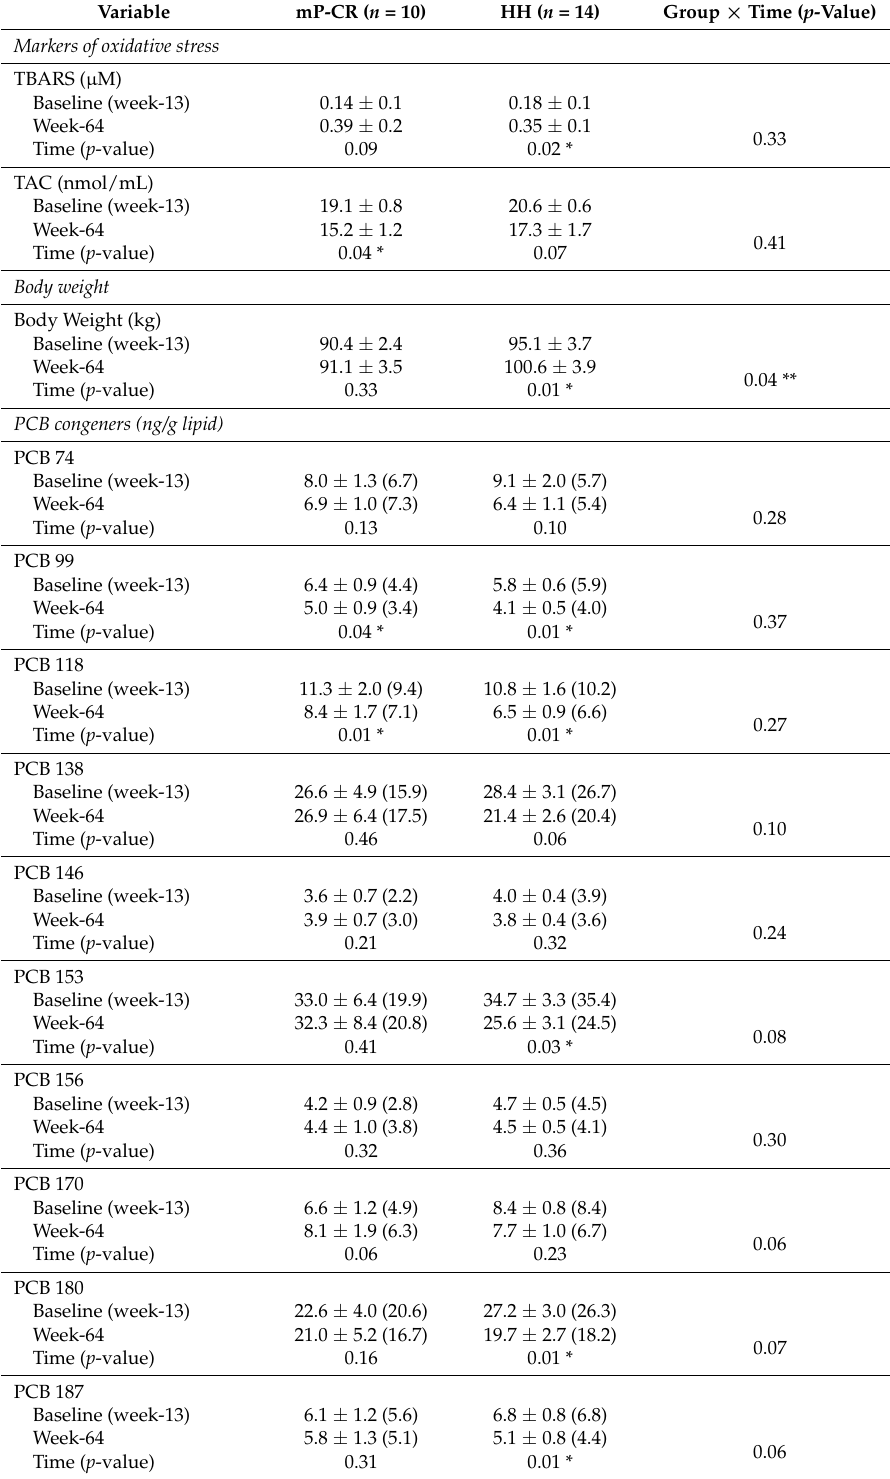
Table 6. Oxidative stress markers, body composition, and PCBs following WM (Phase 2). Variable mP-CR ( n = 10) HH ( n = 14) Group × Time ( p -Value) Markers of oxidative stress TBARS ( µ M) Baseline (week-13) 0.14 ±